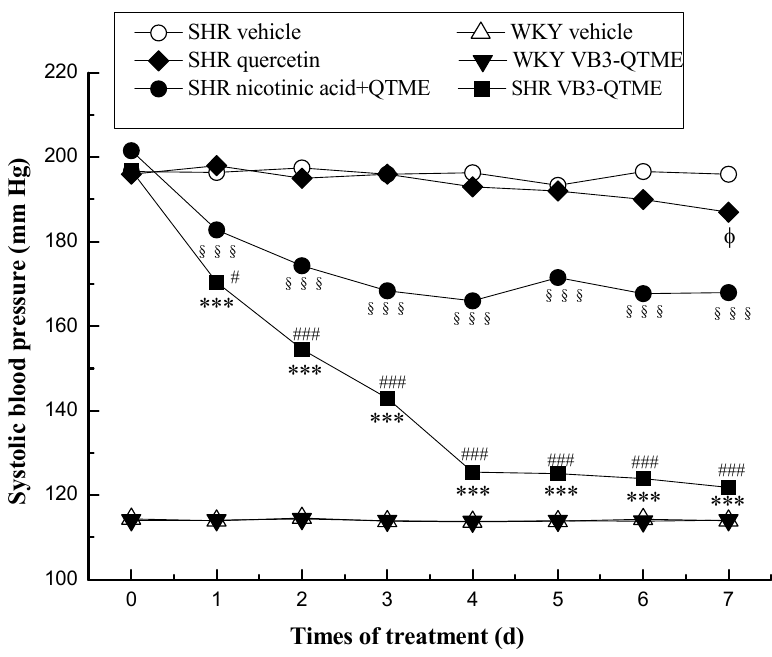
Figure 1. SBP in SHR and WKY rats before and after treatment. Antihypertensive effect of test compounds (SHR VB3-QTME, 15.0 mg/kg/day; SHR nicotinic acid+QTME, 15.6 mg/kg/day; SHR vehicle; WKY VB3-QTME, 15.0 mg/kg/day; WKY vehicle) during continuous feeding in rats. Each point represents the mean SBP in six rats. The data were given as means ± SEM. Comparison between experimental groups were made by using one-way ANOVA, followed by student Newman Keuls test. p values < 0.05